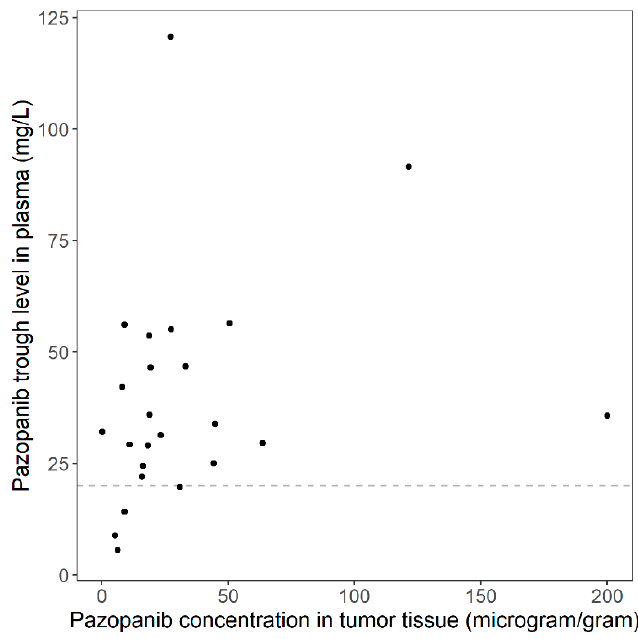
Figure 2. Pazopanib concentrations in tumor tissue versus pazopanib trough levels in plasma ( ρ = 0.41, p = 0.049). The dashed line represents a pazopanib trough level of 20 mg/L, which is advised as the target for adequate drug exposure.